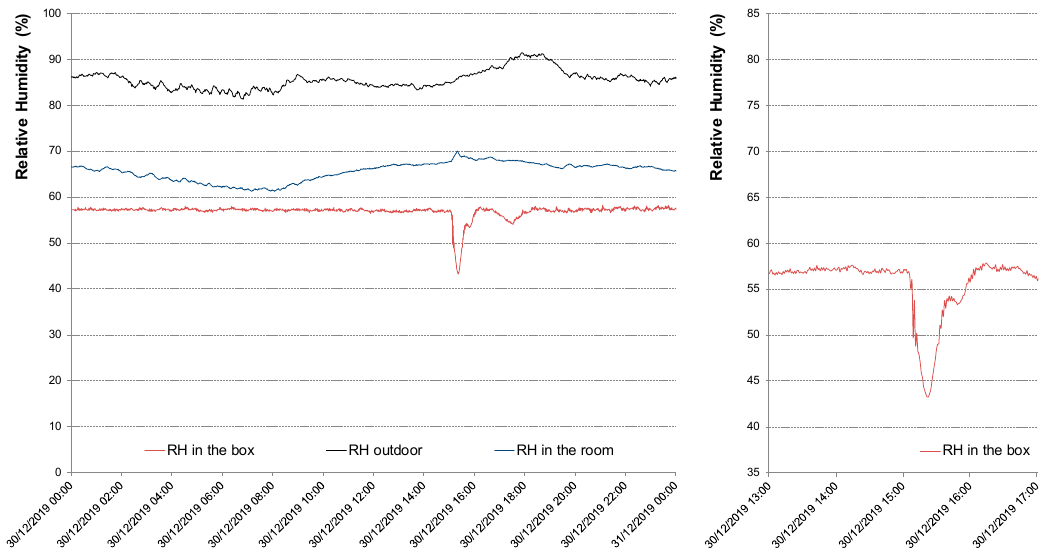
Figure 10. Graphical representation of the monitored parameters [T (°C) an RH (%)] values on December 30th 2019.